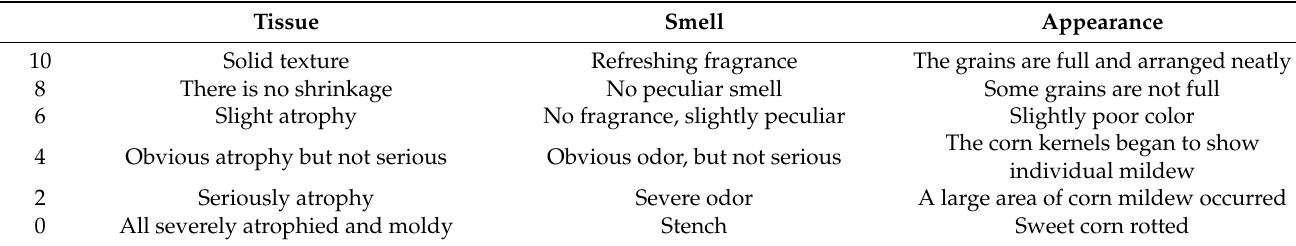
Table 3. Sensory-evaluation